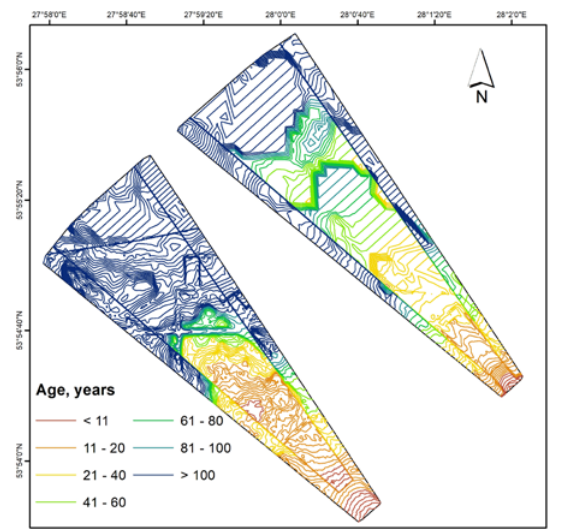
Figure 8. Age of the birch forest in reaching the maximum permissible height